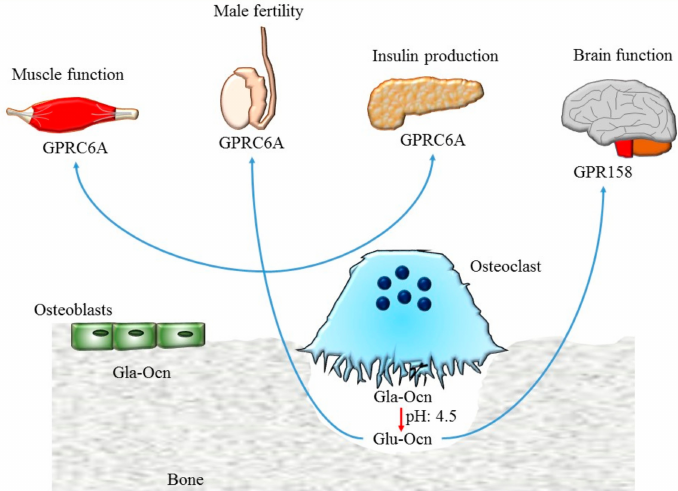
Figure 2. Schematic representation of osteocalcin functions. Osteocalcin stored in the bone matrix in the carboxylated form (Gla–Ocn) is decarboxylated by acidic pH in the resorption lacuna. The undercarboxylated osteocalcin (Glu–Ocn) is released into the circulation and regulates muscle function, male fertility, and insulin secretion by its binding to the GPRC6A receptor while it controls cognitive functions through the GPR158